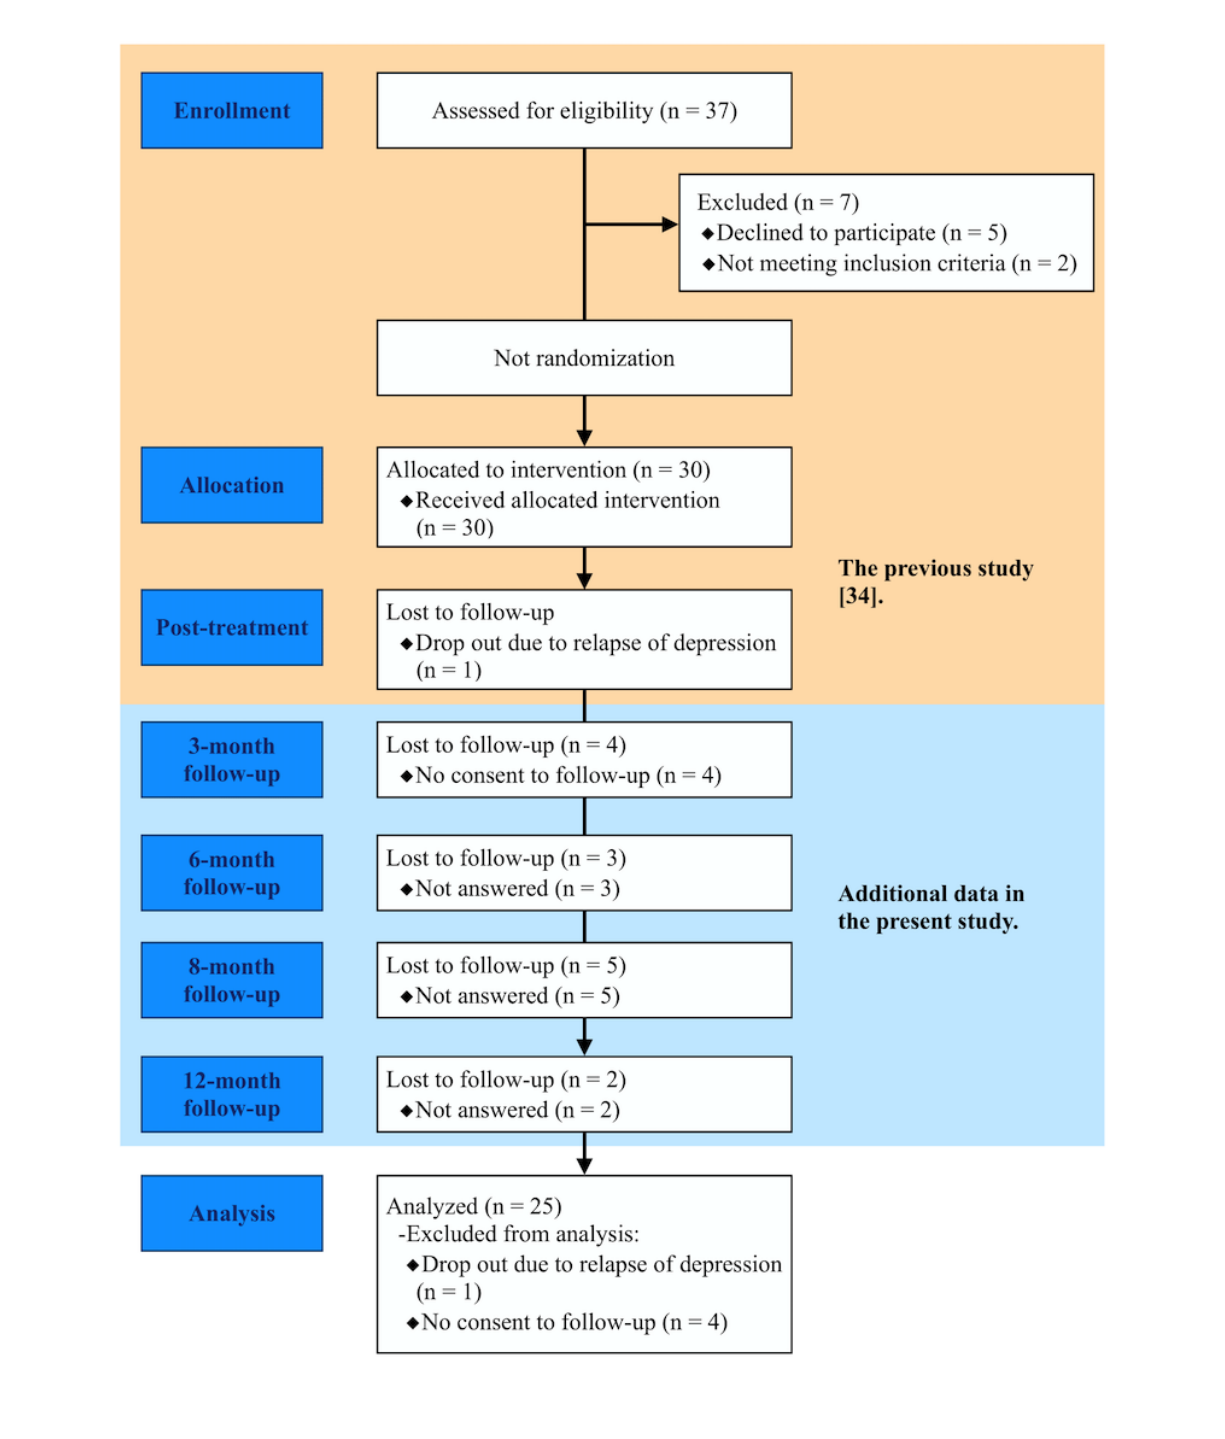
Figure 1. Participant